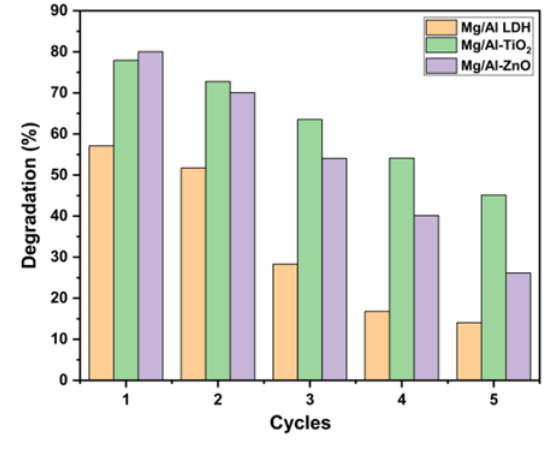
Fig. 7. Photodegradation catalyst regeneration cycle Table 2. Dye degradation percentage of various material